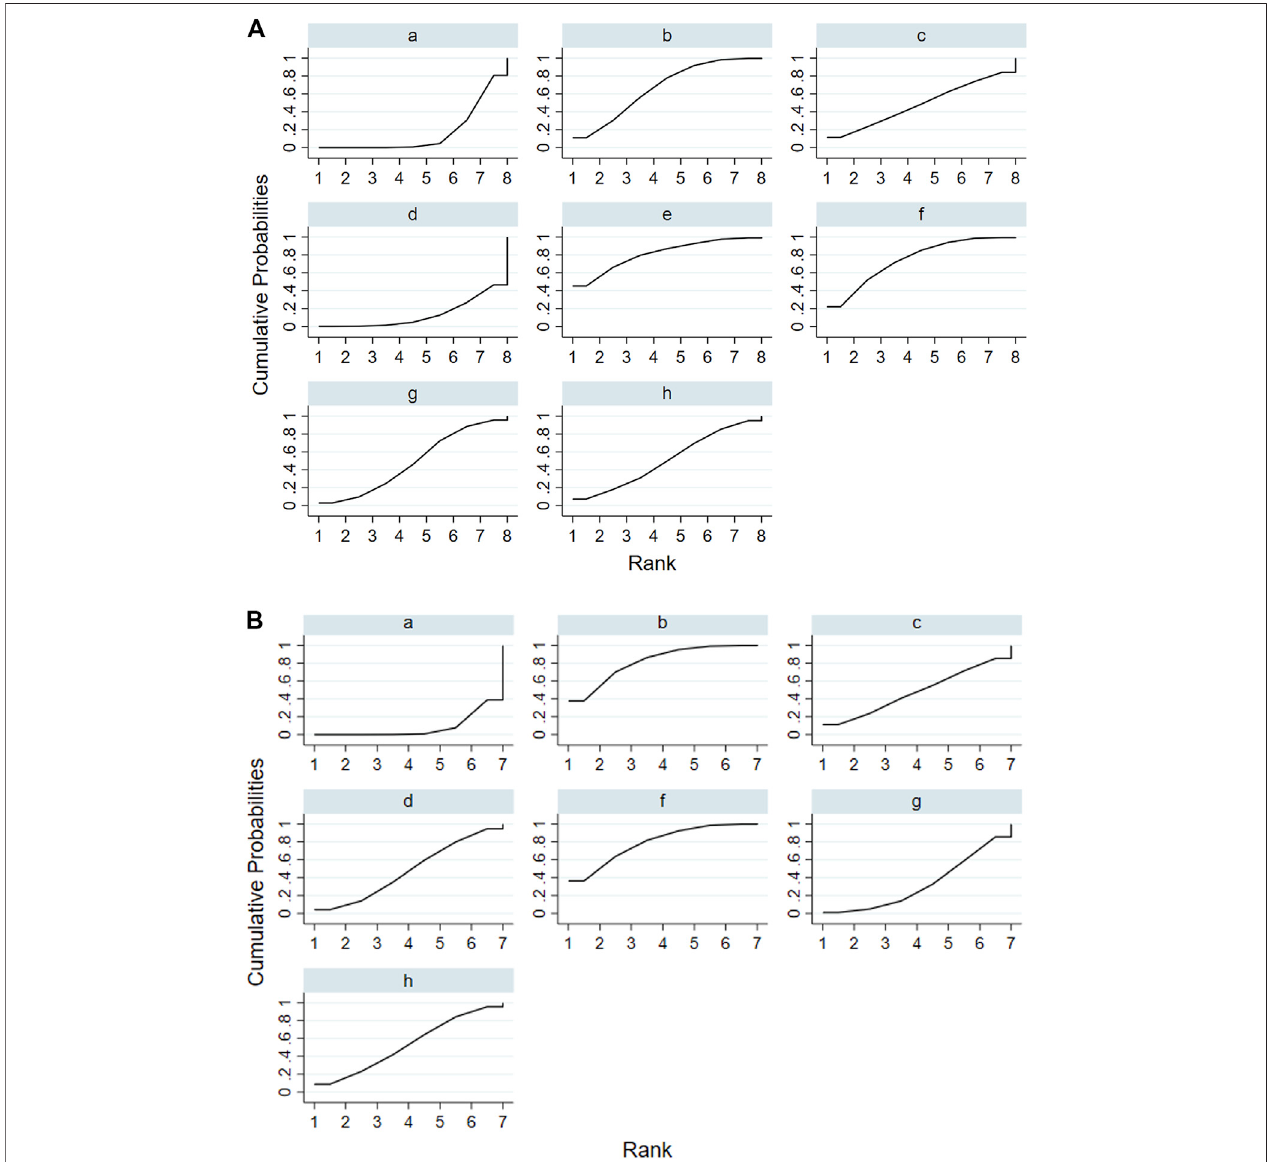
FIGURE8| Surfaceunderthecumulativerankingcurve(SUCRA)ofALTandAST.Notes:(i):UDCA,(ii):Yinzhihuangoralliquid+UDCA,(iii):salviainjection+UDCA, (iv): Yinchenhaodecoction +UDCA, (v): thesimilar prescriptionofYinchenhaodecoction 1+UDCA, (vi):thesimilar prescriptionofYinchenhaodecoction 2+UDCA, (vii): the similar prescription of Yinchenhao decoction 3 + UDCA, and (viii): other traditional Chinese medicine prescriptions + UDCA. (A) ALT. (B) AST.